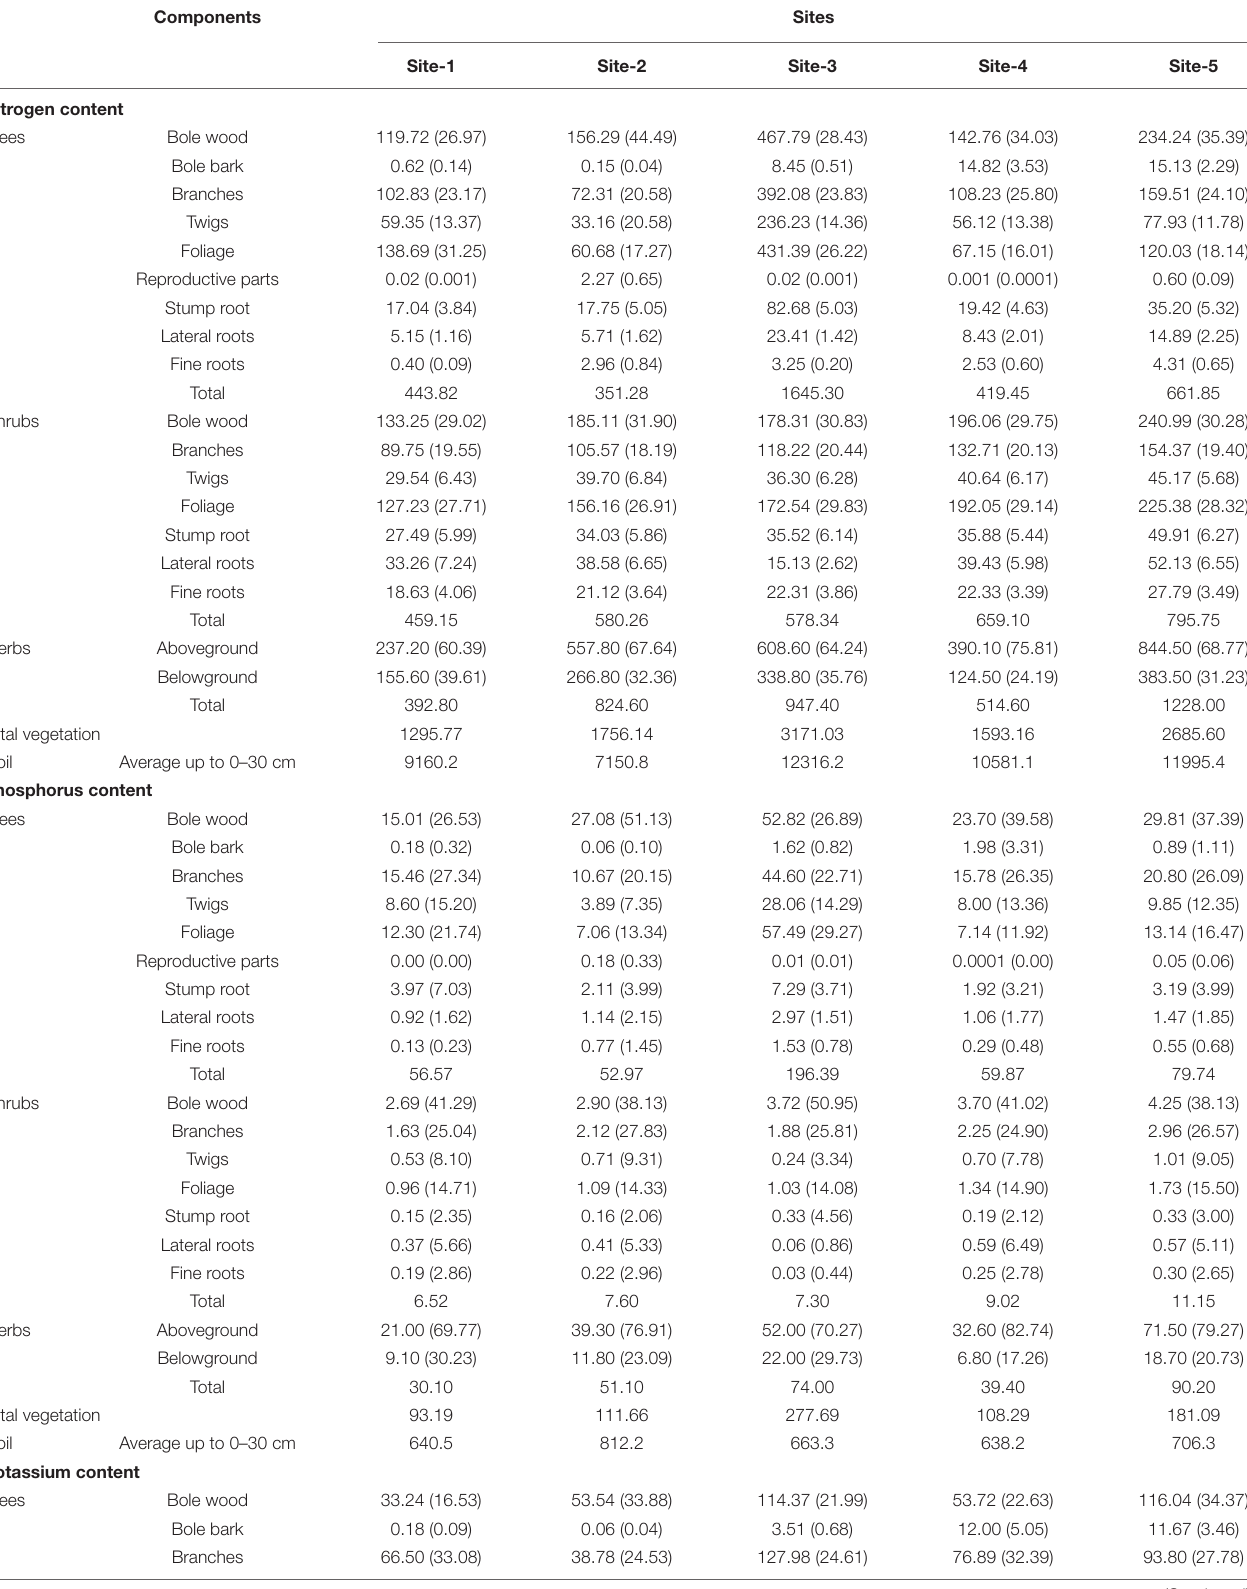
TABLE 3 | Nutrient content (kg ha − 1 ) in different layers of vegetation across the selected study sites (values in parenthesis are percentage of the